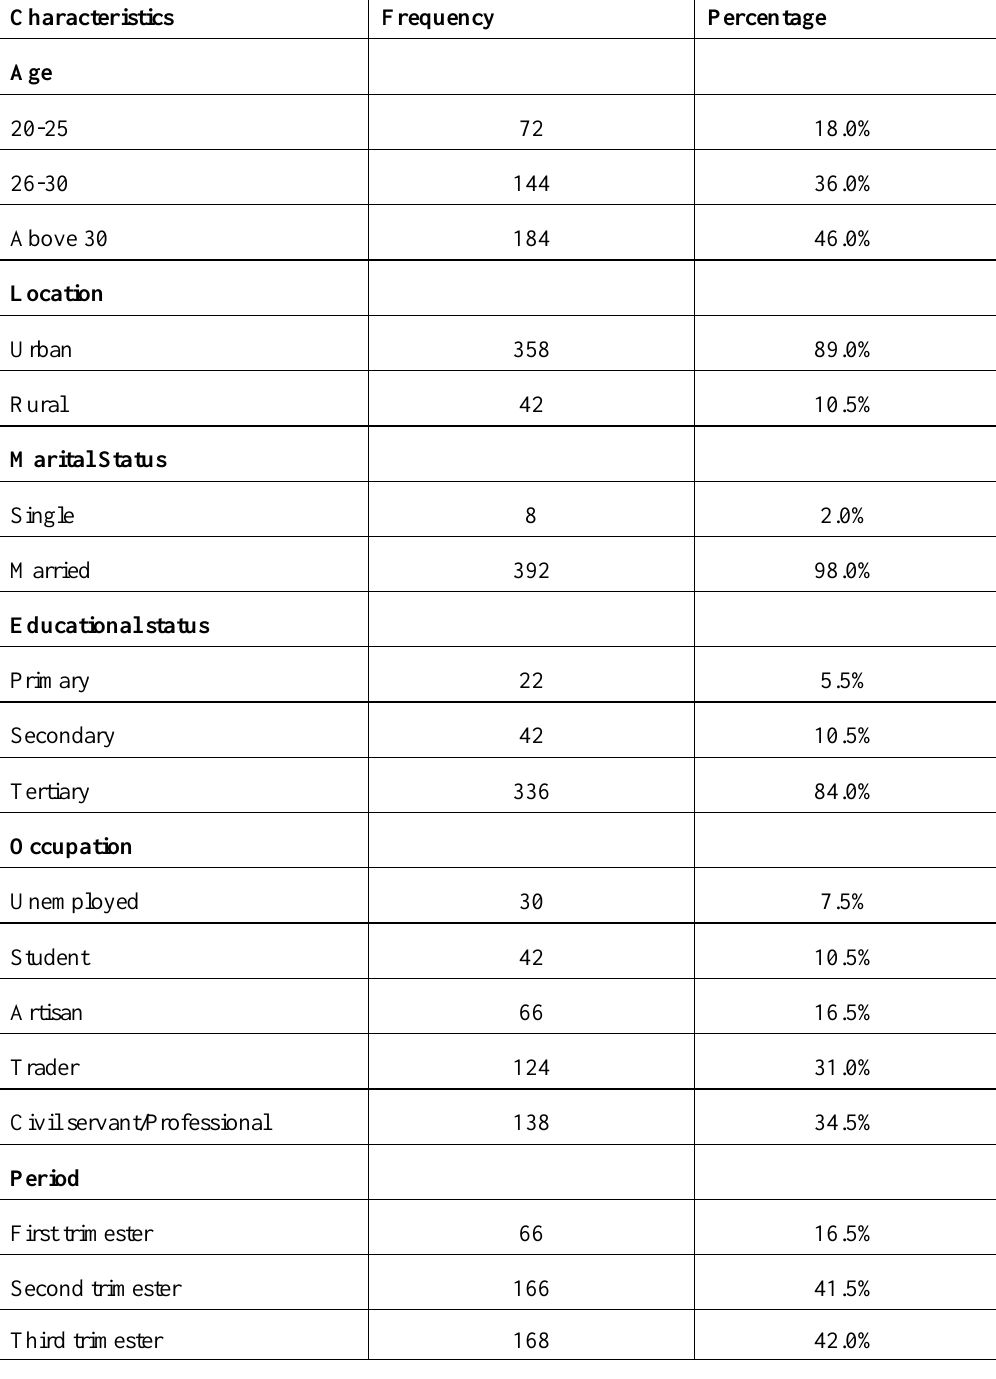
Table 1. Socio-demographic characteristics of pregnant women in Ilorin.